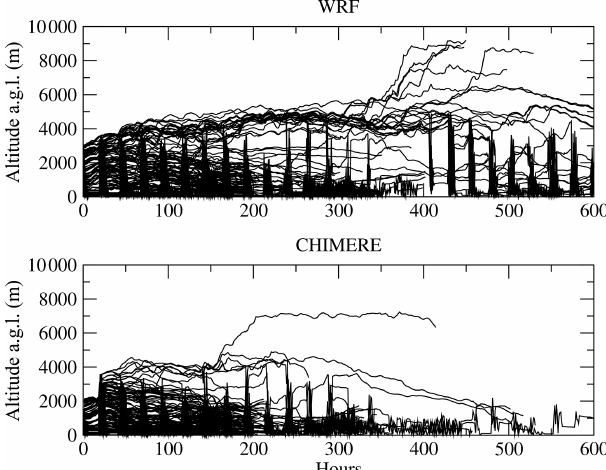
Figure 6. Projection of all back trajectories on a single time–altitude